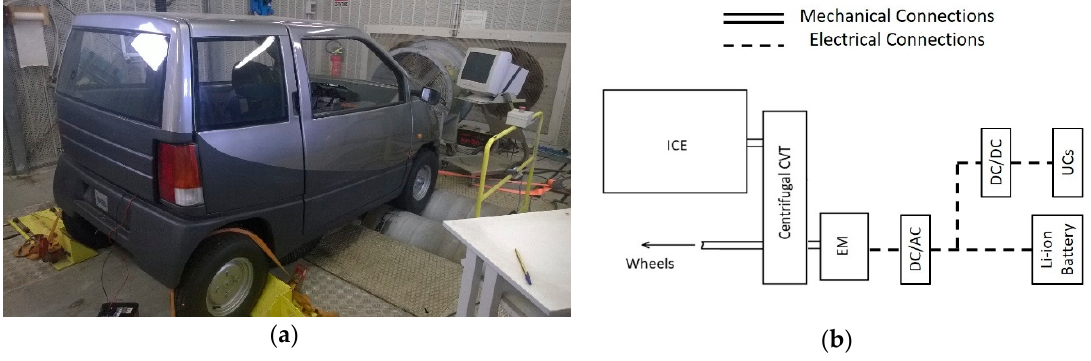
Figure 1. ( a ) Erad Spazia Quadricycle; ( b ) the hybrid powertrain scheme